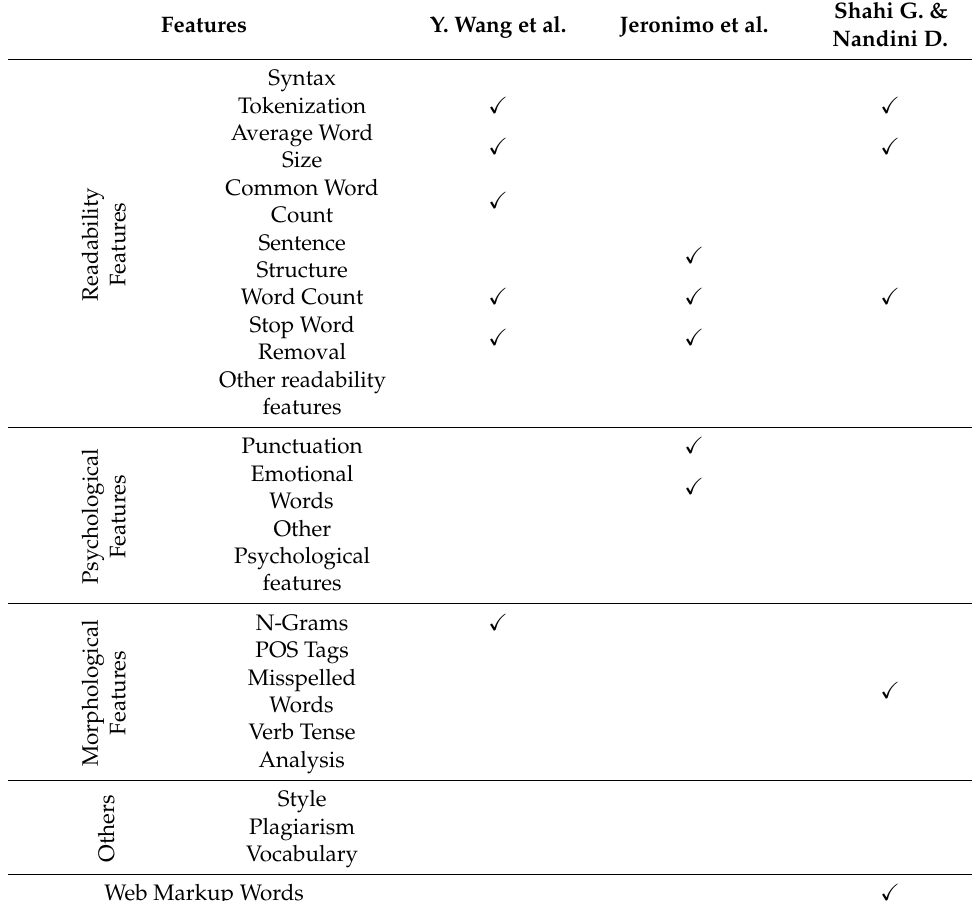
Table 16. Data Pre-Processing Features Used by Multi-Cross Methodologies.